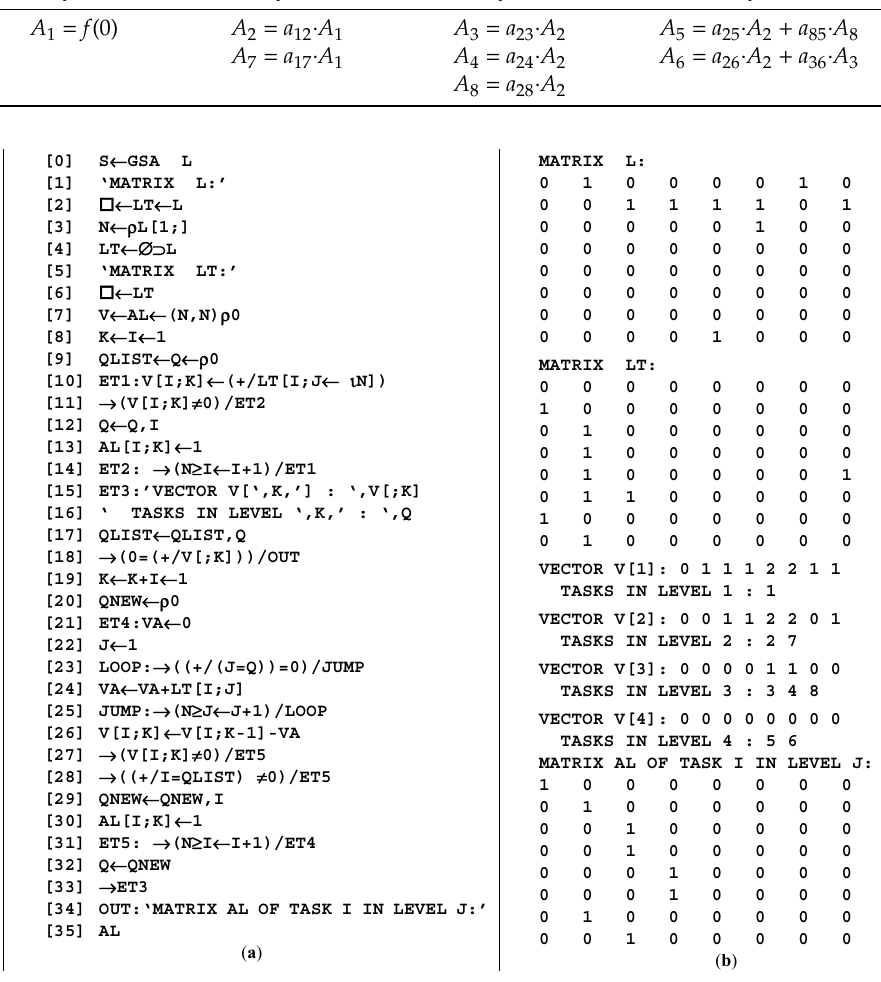
Figure 5. Program function GSA—( a ) program code of the model Ω M ; ( b ) execution.